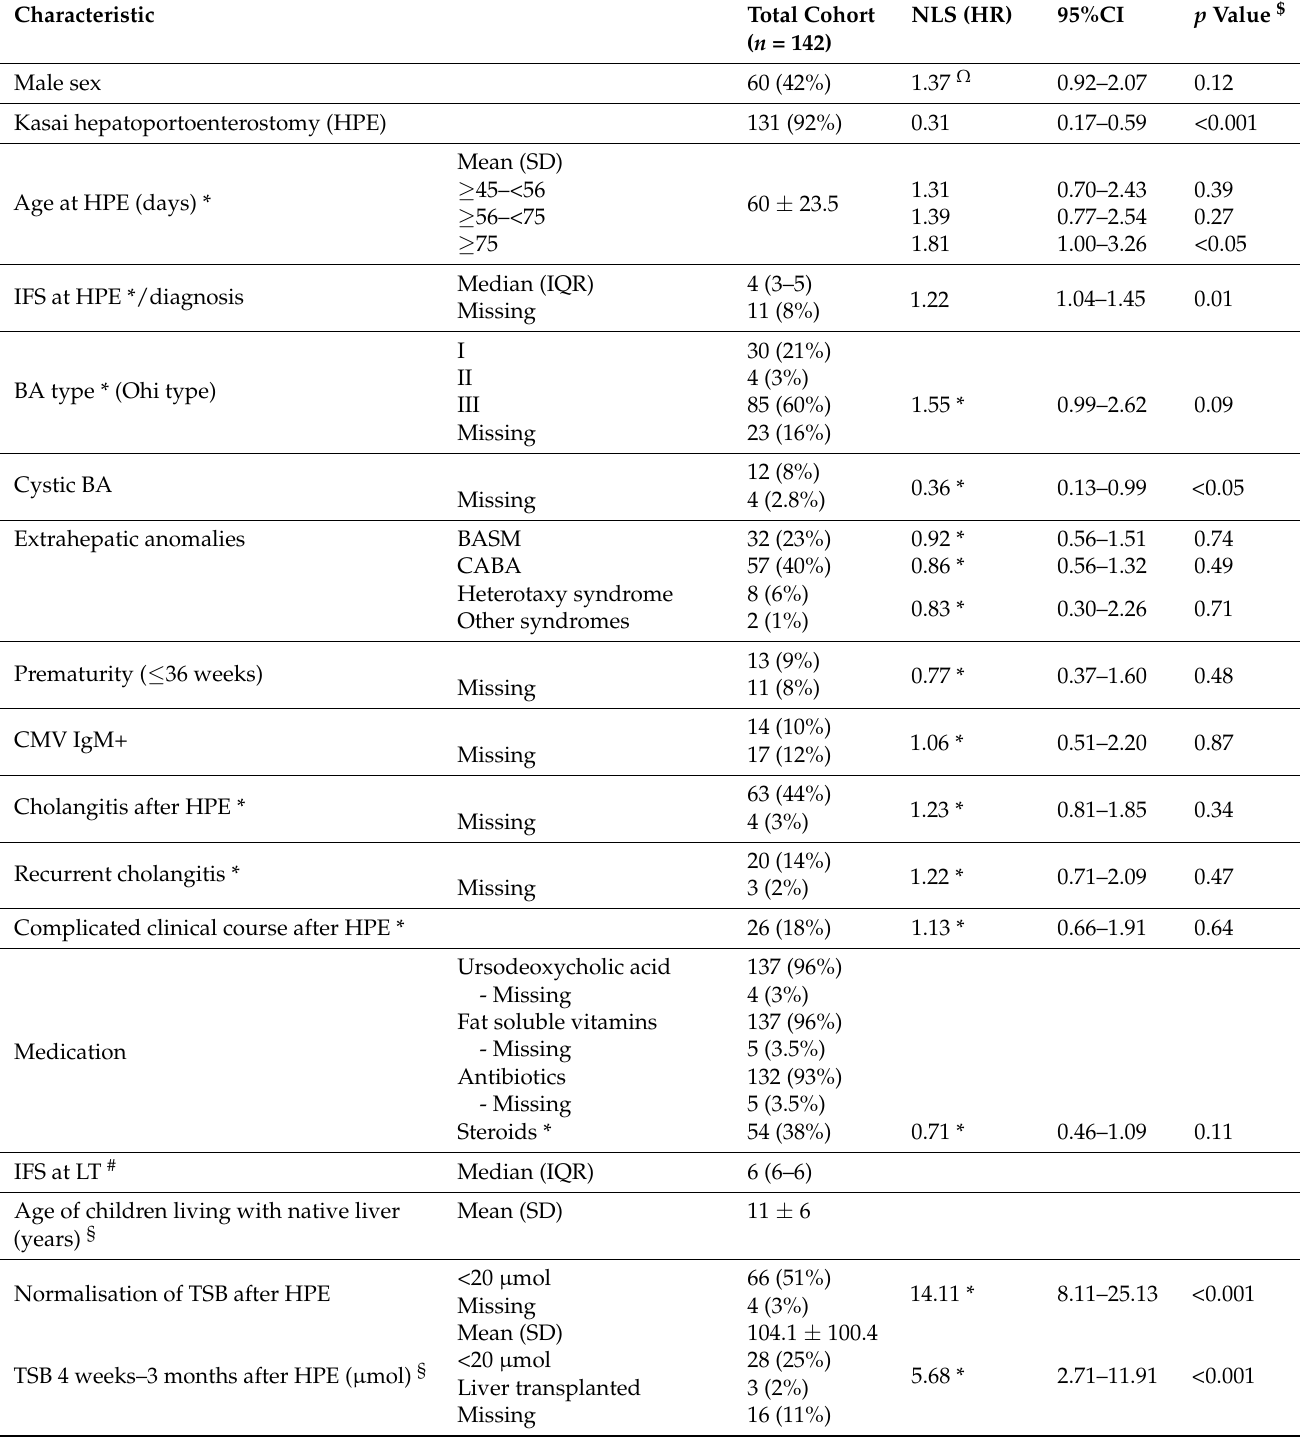
Table 1. Baseline